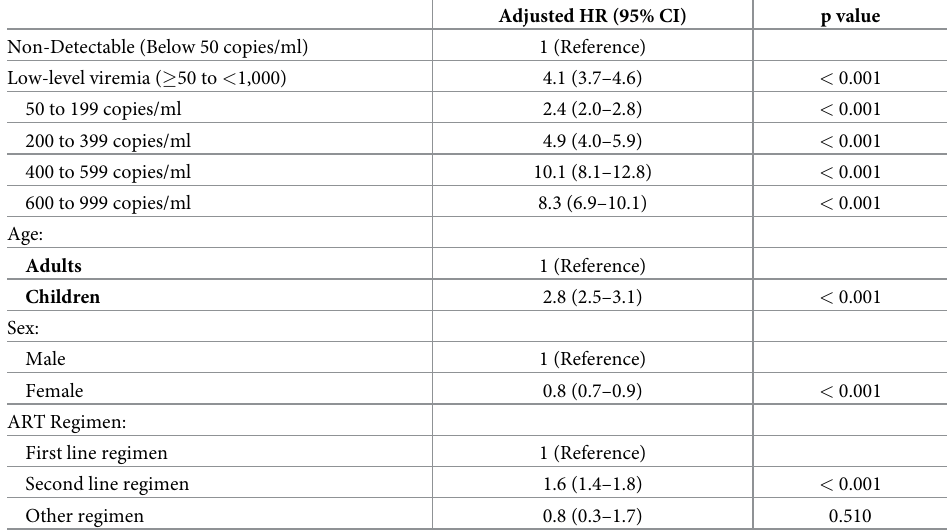
Table 3. The association between low-level viraemia and viral non-suppression as determined through cox pro- portional hazards